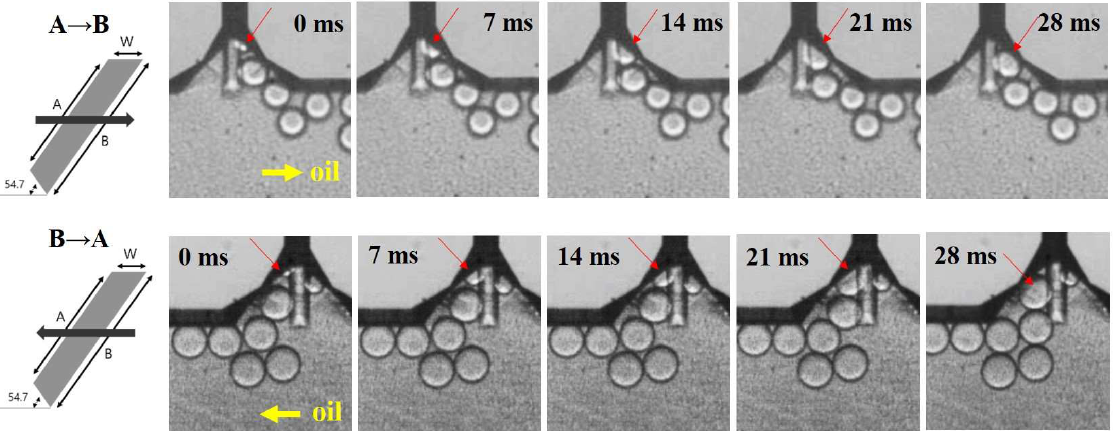
Figure 4. Time-lapse images displaying the micro-droplet generation process at the T-junction region with different oil flow direction (Top: A → B, Bottom: B → A, Channel_A design, oil flow rate: 200µL/h, water (sample) flow rate: 50 µL/h).